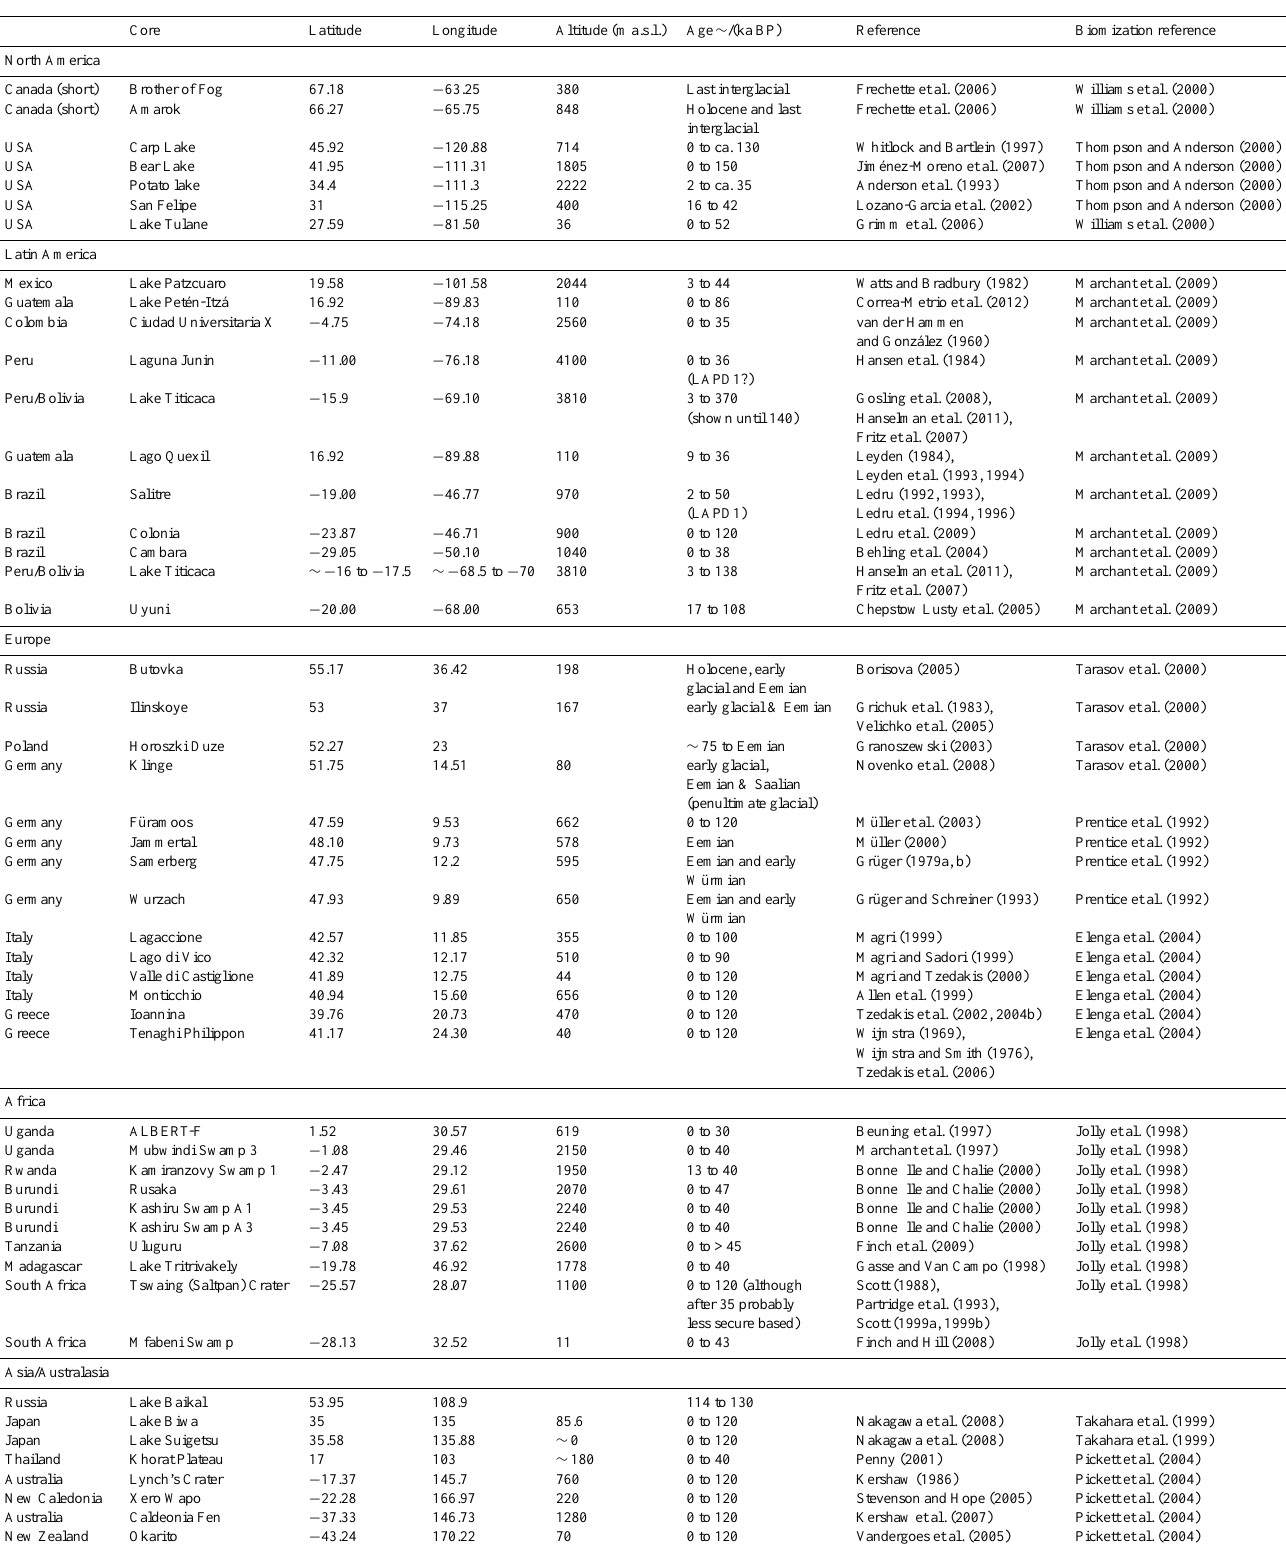
Table 2. Details of the locations of pollen-data records synthesized in this study. Core Latitude Longitude Altitude (ma.s.l.) Age ∼ /(ka BP) Reference Biomization